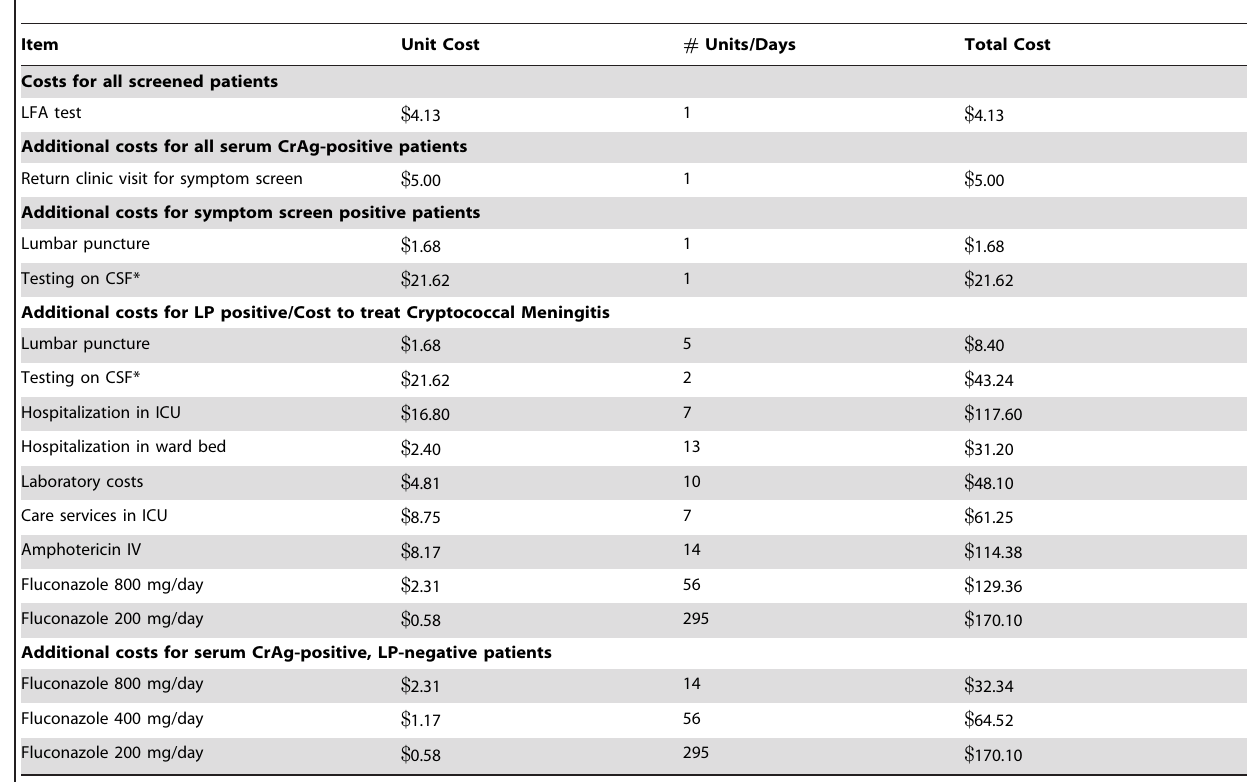
Table 1. Costs associated with cryptococcal meningitis diagnosis, treatment and a cryptococcal screening program in Vietnam, in US dollars.